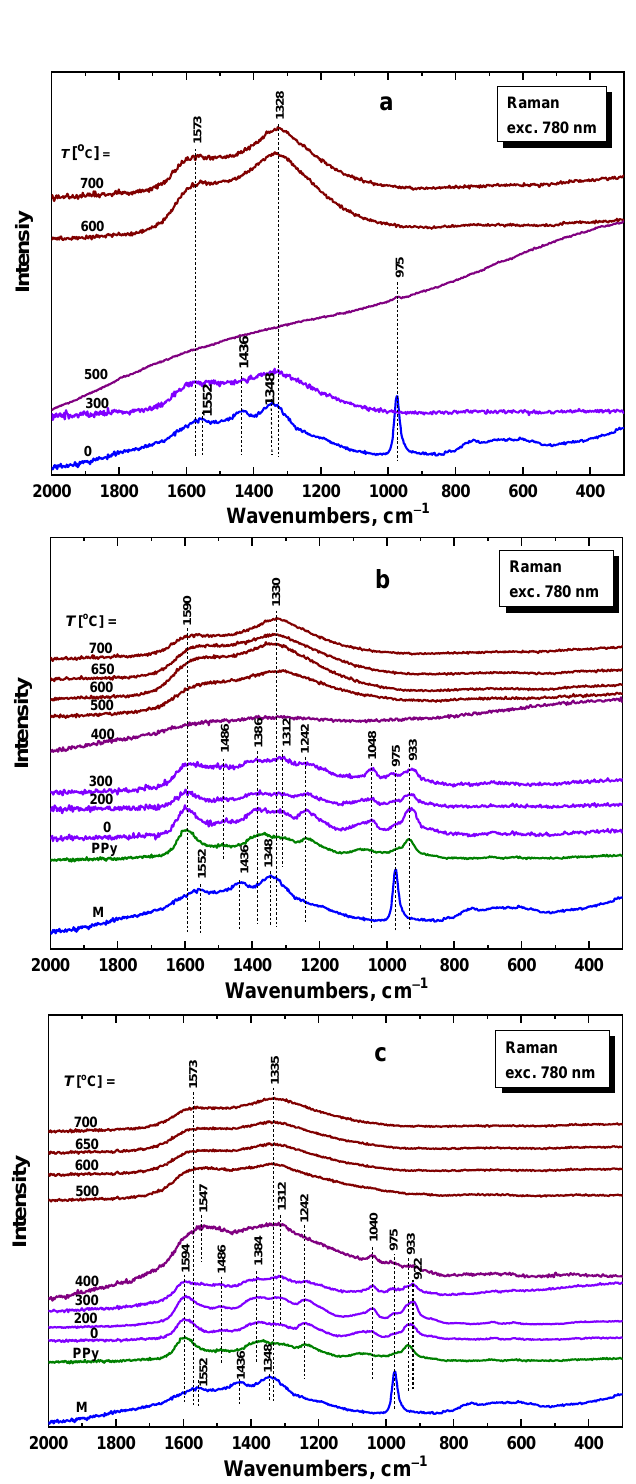
Figure 8. Evolution of the Raman spectra of ( a ) the melamine sponge (M), ( b ) melamine sponge coated with 8.2 wt%, and ( c ) 27.4 wt% polypyrrole, after exposure to various temperatures in inert atmosphere. Laser excitation line was 780 nm. Polypyrrole (PPy) spectrum is included for comparison. The groups of similar spectra are distinguished by colours.